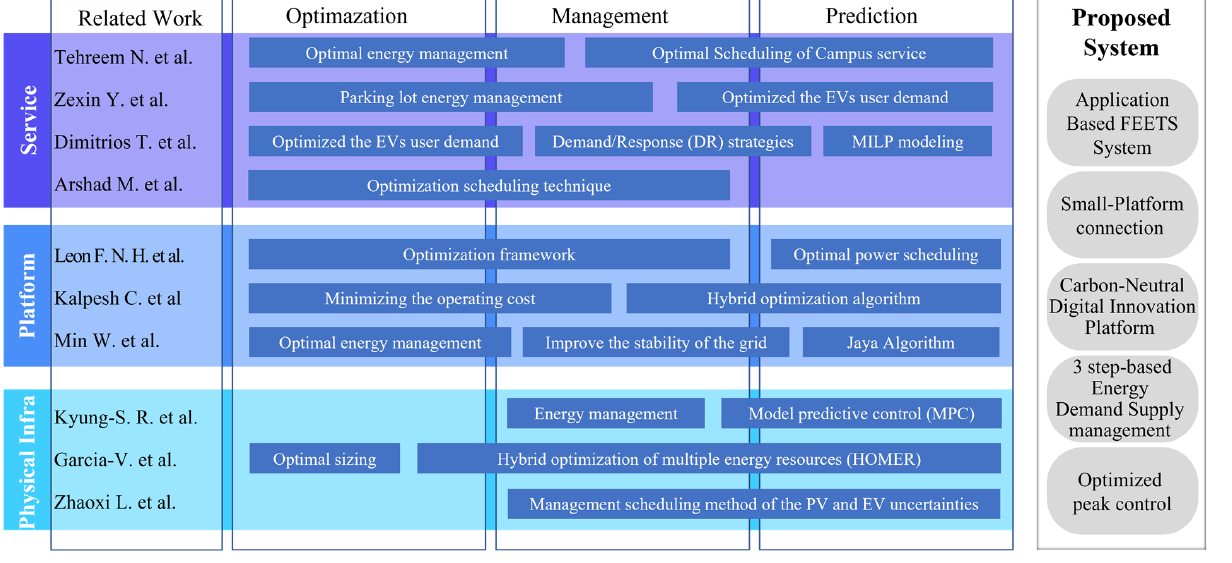
Figure 2. Related Work Domain Analysis and Difference of Proposed System